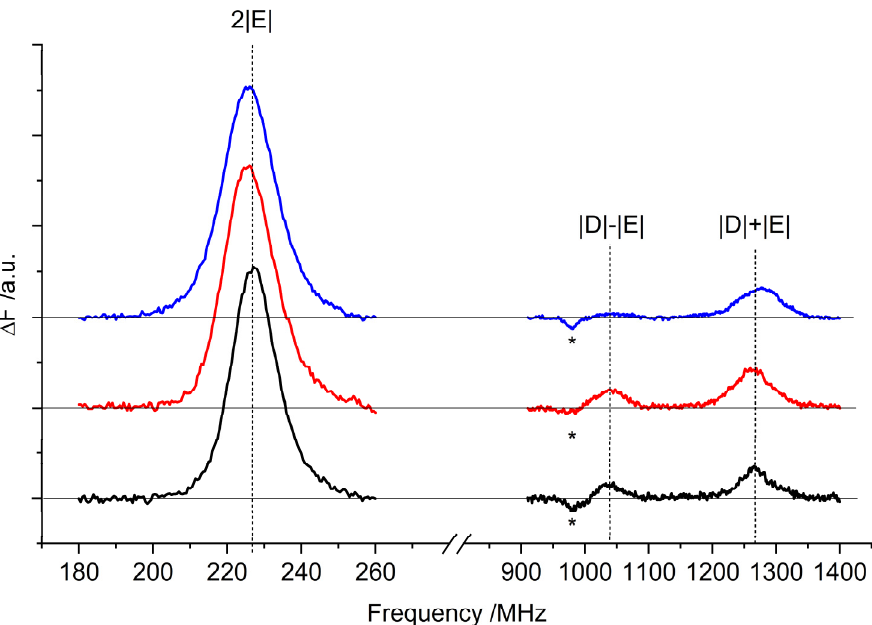
Figure 3. 3 Car FDMR spectra of WT (black), lut2 (red), and lut2 npq2 (blue) LHCII variants detected at 680 nm. Amplitude modulation frequency: 333 Hz; temperature: 1.8 K. The FDMR spectra were vertically translated for a better comparison. Note that the negative component to the left-hand side of the |D| − |E| transition (indicated by an asterisk) is assigned to a chlorophyll triplet (see below).